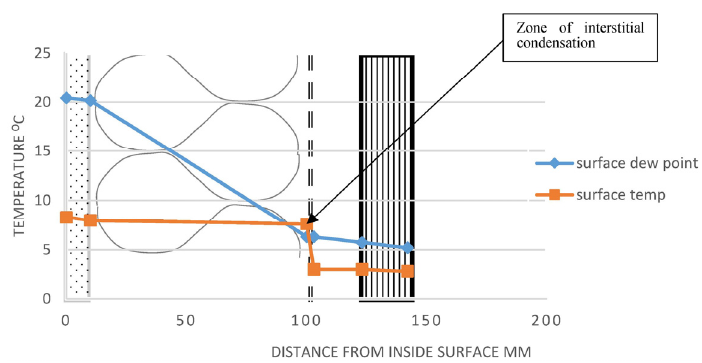
Figure 2. Interstitial condensation calculations in the control house.